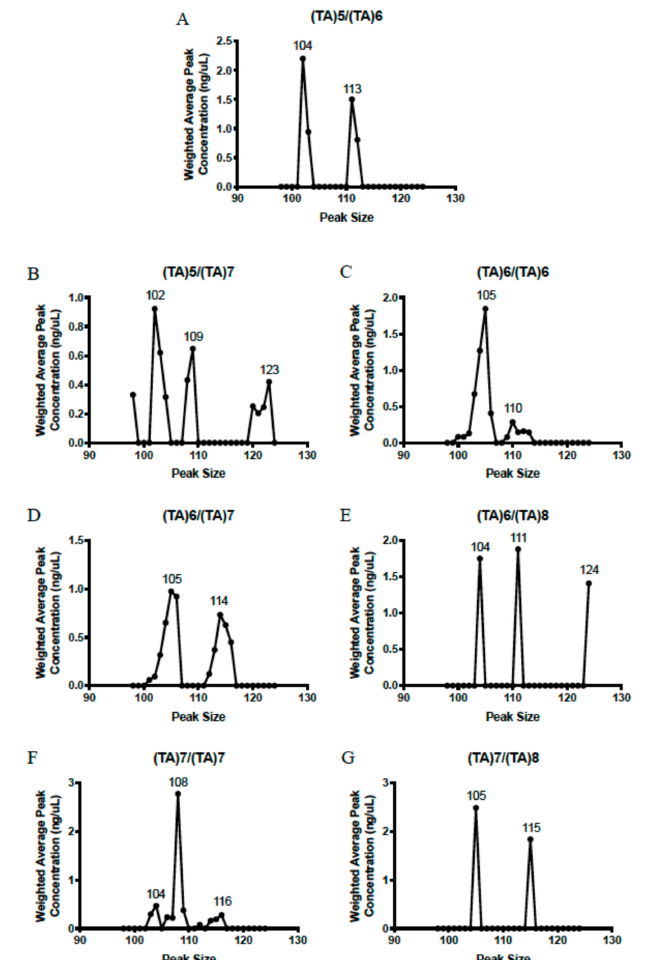
Figure 3. Weighted averages of each peak size were calculated for all samples that underwent gel sizing analysis. Genotypes represented in this figure were determined by Illumina (MiSeq), fragment analysis, and fPCR, as gel sizing was ine ff ective on its own: ( A ) UGT1A1*36 / *1 , ( B ) UGT1A1*36 / *28